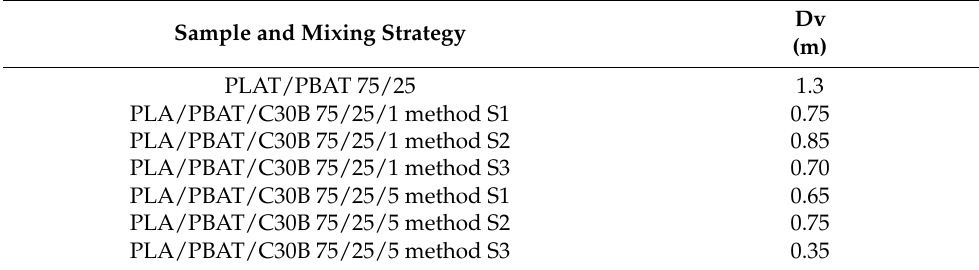
Table 5. Average diameter of the droplet, Dv (data with permission from Ref. [127] Copyright 2016